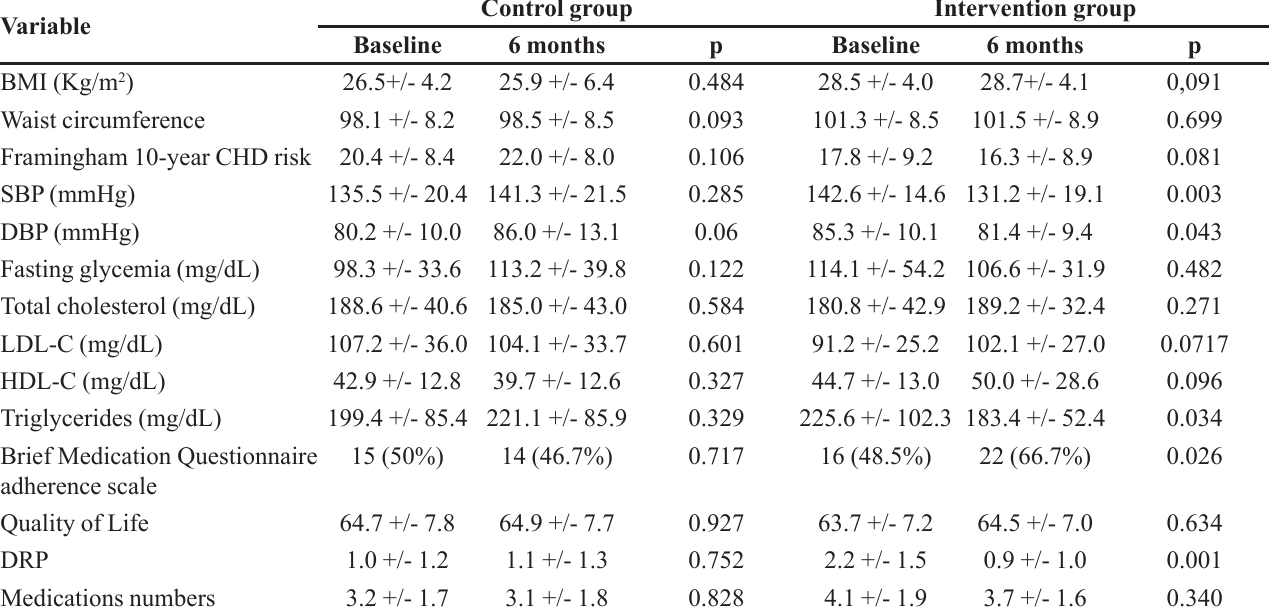
TABLE III - Comparison of parameters at baseline and after 6 month follow-up, n (%), mean ± S.D.